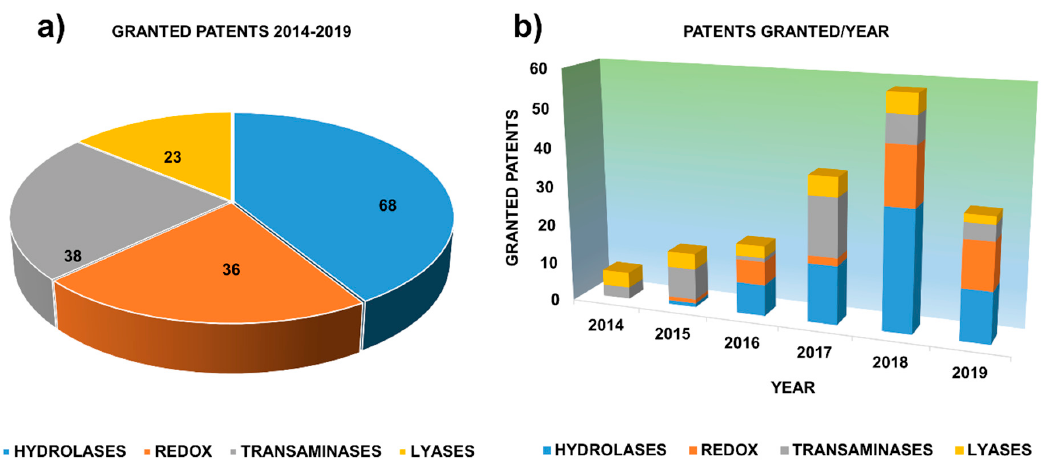
Figure 1. Patents granted in 2014–2019 employing the most usual types of enzymes, according to several patent engine servers (e.g., Espacenet, SciFinder, Google Patents).